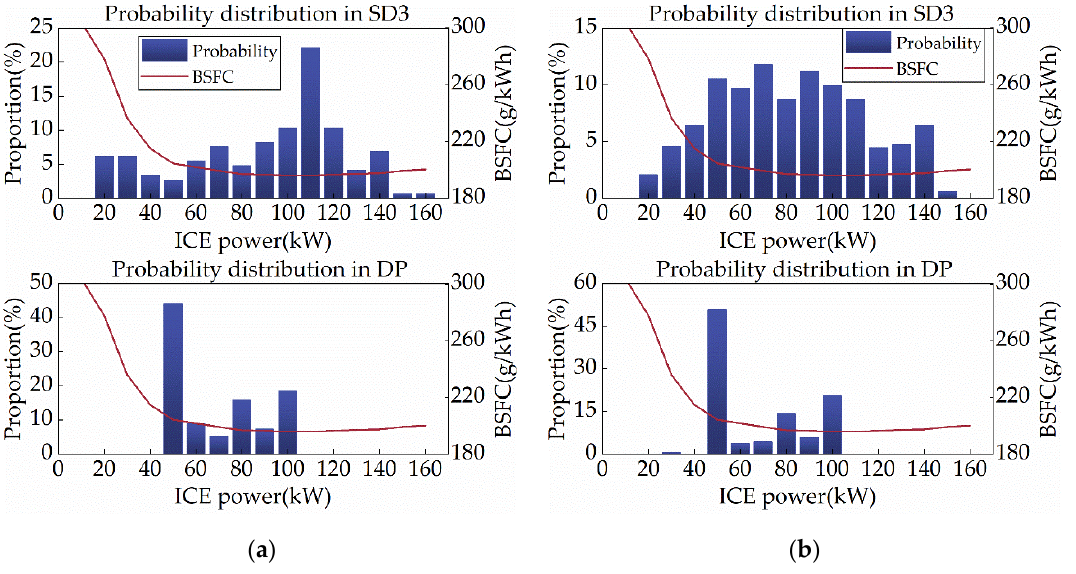
Figure 11. ICE power distribution under different driving cycles. ( a ) CHTC-B; ( b ) WVUCITY.